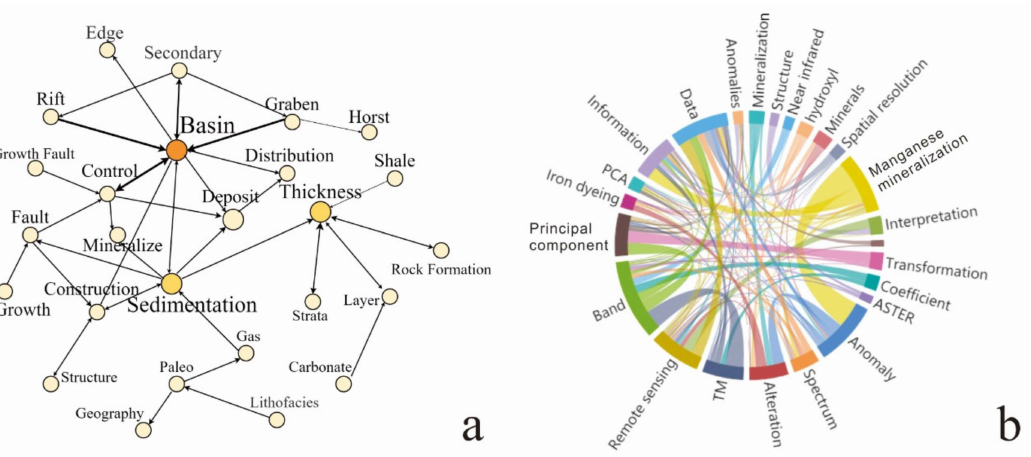
Figure 4. The examples of ternary diagram and chord diagram: ( a ) ternary diagram of metallogenic background; ( b ) chord diagram of remote